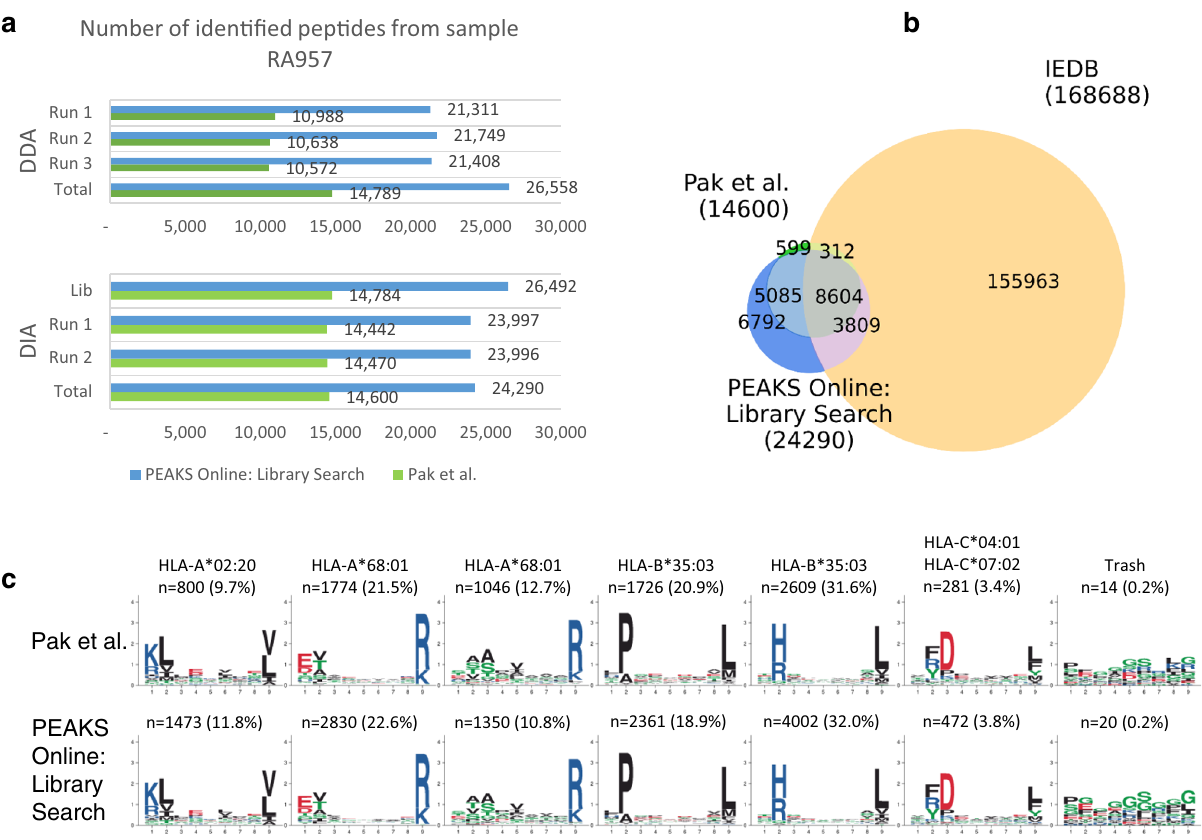
Fig. 2 Comparison of DIA spectral library search results by Pak et al. 21 and PEAKS Online on the immunopeptidomics sample RA957. a Sample-speci fi c spectral libraries were built from the database search results of three DDA runs. The libraries were subsequently used to search two DIA runs. b Venn diagram of the identi fi ed peptides and the HLA-I peptides from the Immune Epitope Database (IEDB). c Binding motif deconvolution of the identi fi ed peptides by MixMHCp 2.1. (DDA: Data-Dependent Acquisition; DIA: Data-Independent Acquisition; IEDB: Immune Epitope